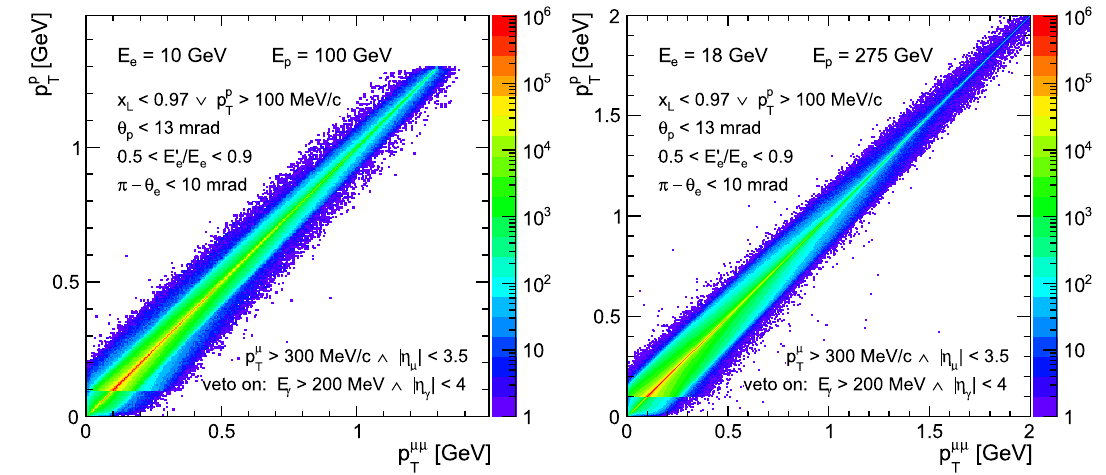
μμ , and the proton transverse momentum, p p T